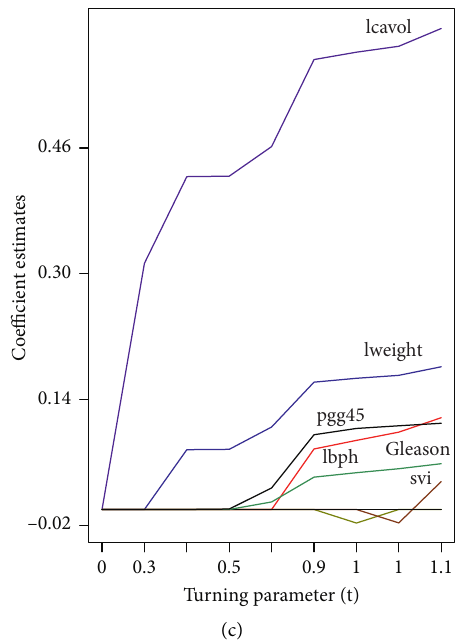
Figure 3: Coefficient paths of the (a) LASSO, (b) Enet, and (c) SRLASSO versus t � 􏽐 p